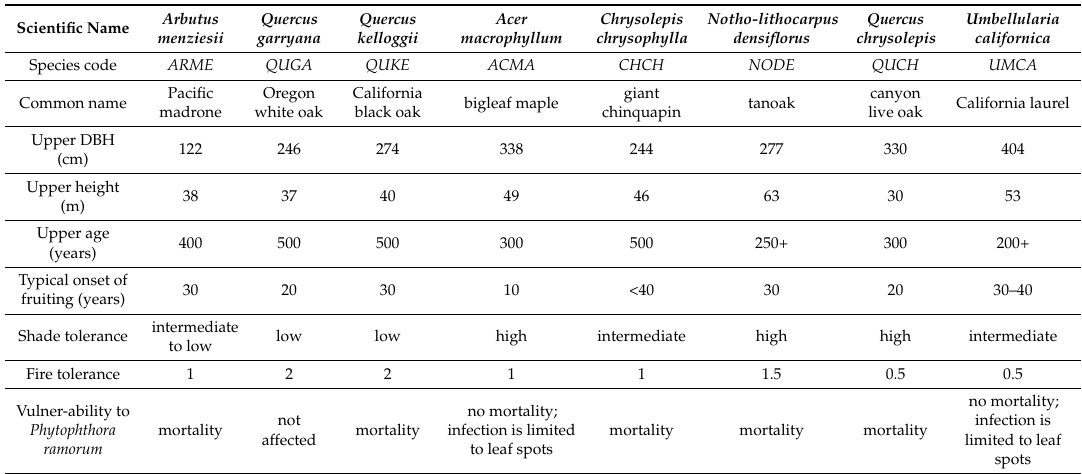
Table 1. Hardwood species included in the analysis and attributes related to size, age, and